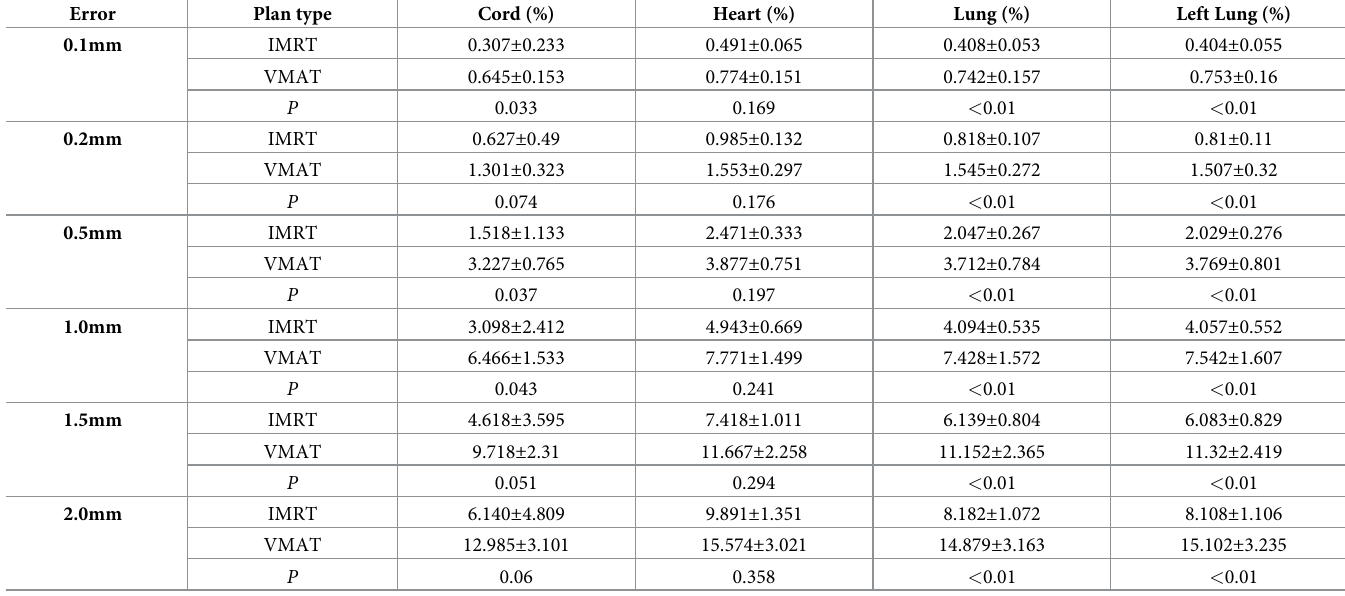
Table 2. The gEUD variation in the OAR of the IMRT and VMAT plan for opening error.